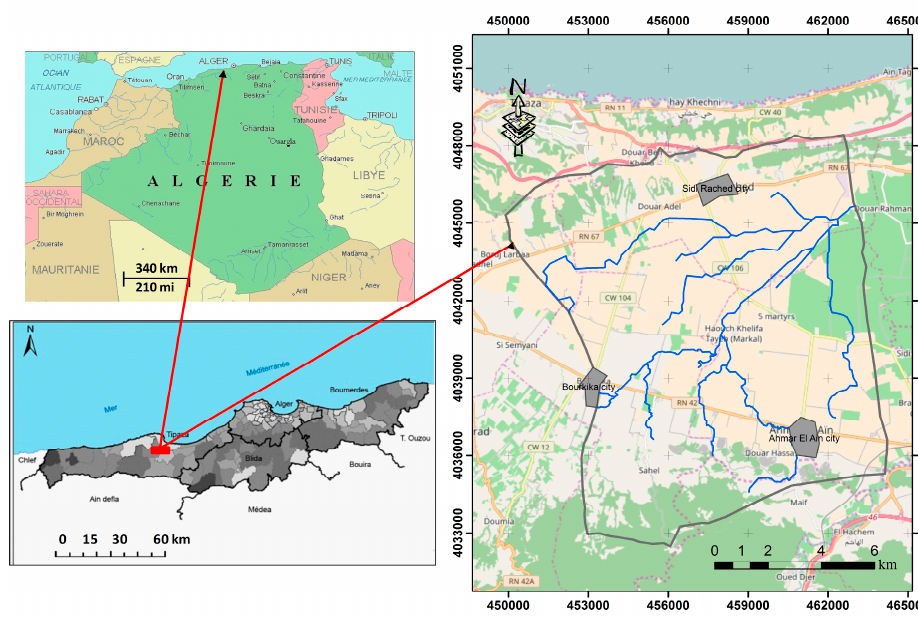
Figure 1. Location map of the Sidi Rached plain.